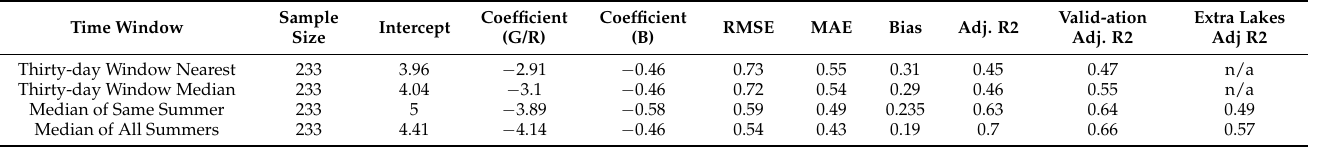
Table 1. Regression models estimating in situ CDOM( a 440 ) from Landsat 8 B3/B4 and B2 surface reflectance for different time windows. RMSE = root mean square